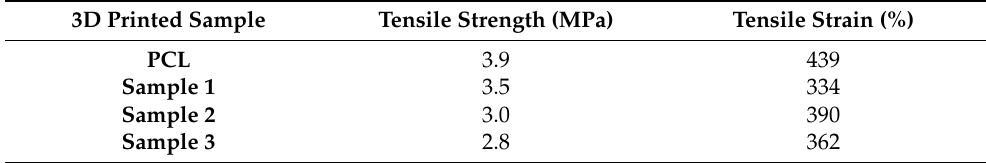
Table 2. Tensile strength and strain of 3D-printed